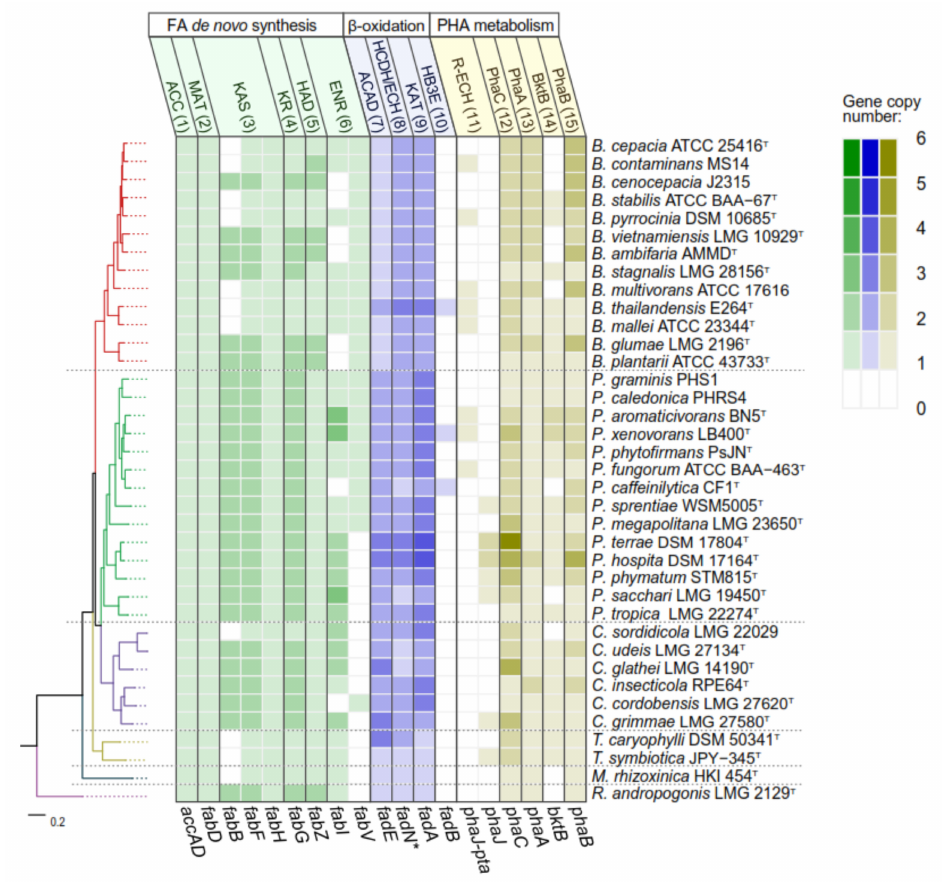
Figure 5. Genomic comparison of the metabolism for the conversion of fatty acids into PHA by Burkholderia sensu lato strains. Enzymes functions and their respective coding genes are listed above and below the graph, respectively. Number shown in parenthesis following the enzyme activity correspond to reactions shown in Figures 2 and 3. Color intensity depicts the gene copy number as showed in legend. Homology prediction of 27 strains was performed using the curated metabolic networks of the Kyoto Enzyme and Genomes Database (KEGG) and manual Blast search through Bidirectional Best Hit approach (BBH). For the 10 strains belonging to novel genera (e.g., Caballeronia , Trinickia , Mycetohabitans , Robbsia ) a manual reconstruction through BBH was performed. An amino acid sequence identity of >30% and ≥ 70% coverage was used as threshold in function of the gene context for homology prediction. Genomes were retrieved from Refseq database. Strains are arranged according to a phylogenomic tree constructed from a concatenate of 38 core genes present in the 37 genomes using Phylophlan and MAD root software. ACC, acetyl-CoA carboxylase; MAT, malonyl-CoA-ACP transacylase; KAS, class I-III β -ketoacyl-ACP synthases; KR, 3-ketoacyl-ACP reductase; HAD, β -hydroxyacyl-ACP-dehydratase; ENR, enoyl-ACP reductase; ACAD,